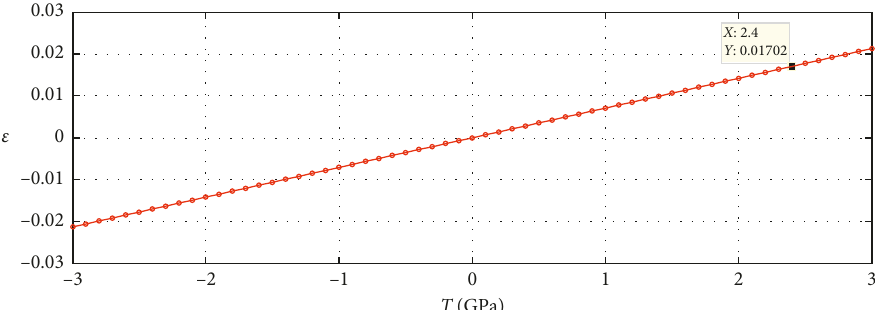
Figure 3: The variation of the strain generated with the (001) biaxial tensile